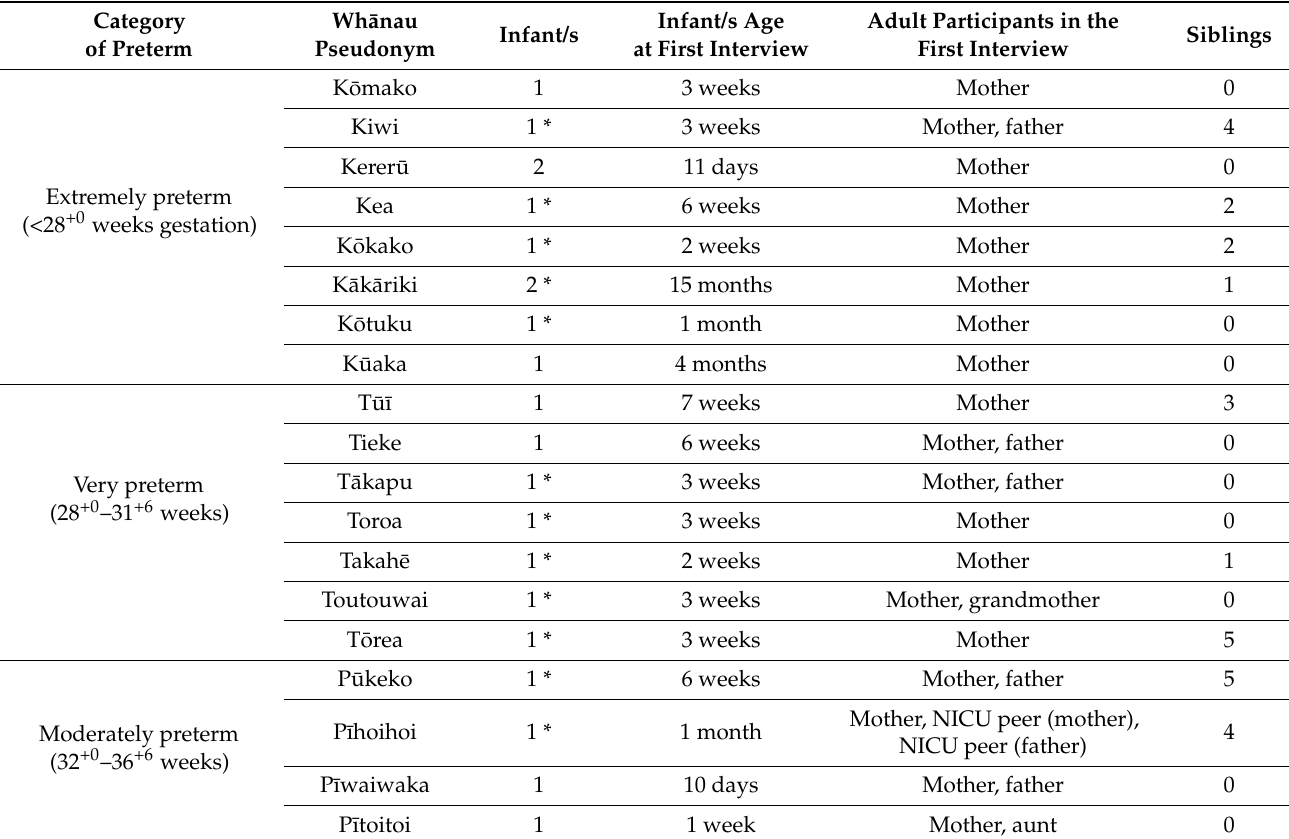
Table 1. Wh¯anau